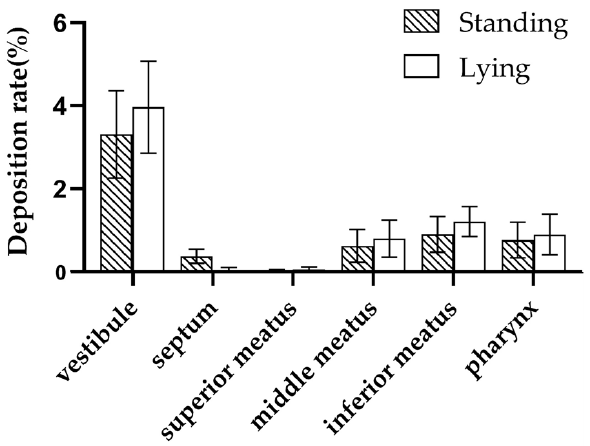
Figure 8. Deposition rate of A. niger spores at each anatomical site of nasal cavity under the 15 L/min inspiratory condition in standing and lying positions.